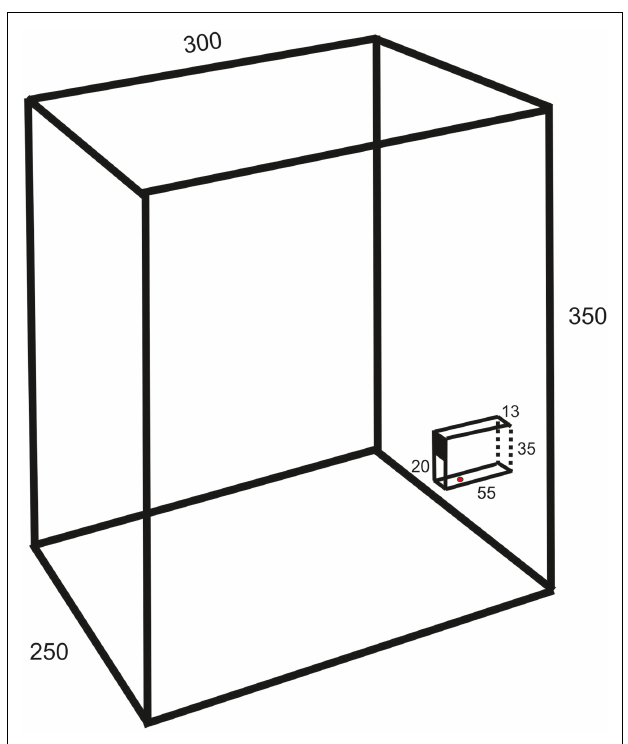
FIGURE 1 | Schematic drawing of the test box (oblique lateral view; measurements in millimeters) showing the behavioral paradigm with a vertical slit formed by glass walls .The upper part of the space between the vertical walls is covered so that the height of the slit is 20mm.